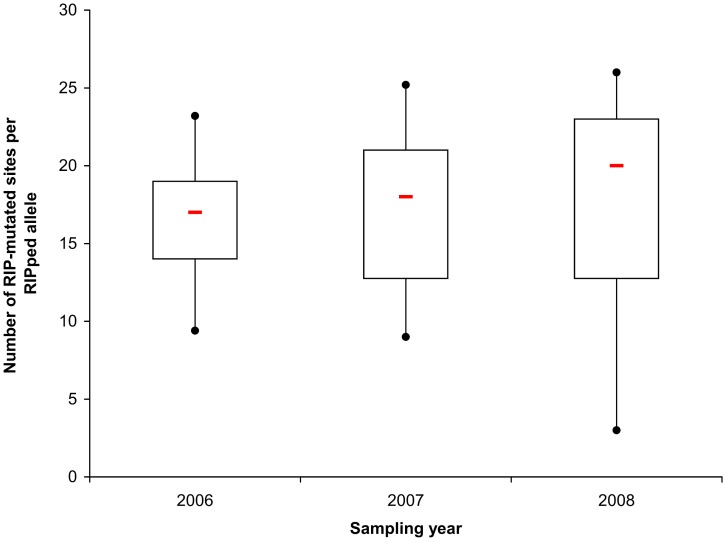
Distribution of the number of RIP mutations in the AvrLm4-7 gene over sampling years.The number of RIP mutations along the AvrLm4-7 gene were counted for each RIPped allele and over the three L. maculans sexual cycles monitored in the experimental trial. The red line represents the median value; the boxes include values between the first and the third quartile of the distribution; circles, 1st and 9th deciles, respectively. In 2007 and 2008, isolates collected the same year at the phoma leaf spot stage and at the stem canker stage from the previous growing season residues have been pooled because they correspond to the same generation after the start of the experiment. In 2006, isolates were collected from phoma leaf spots only.